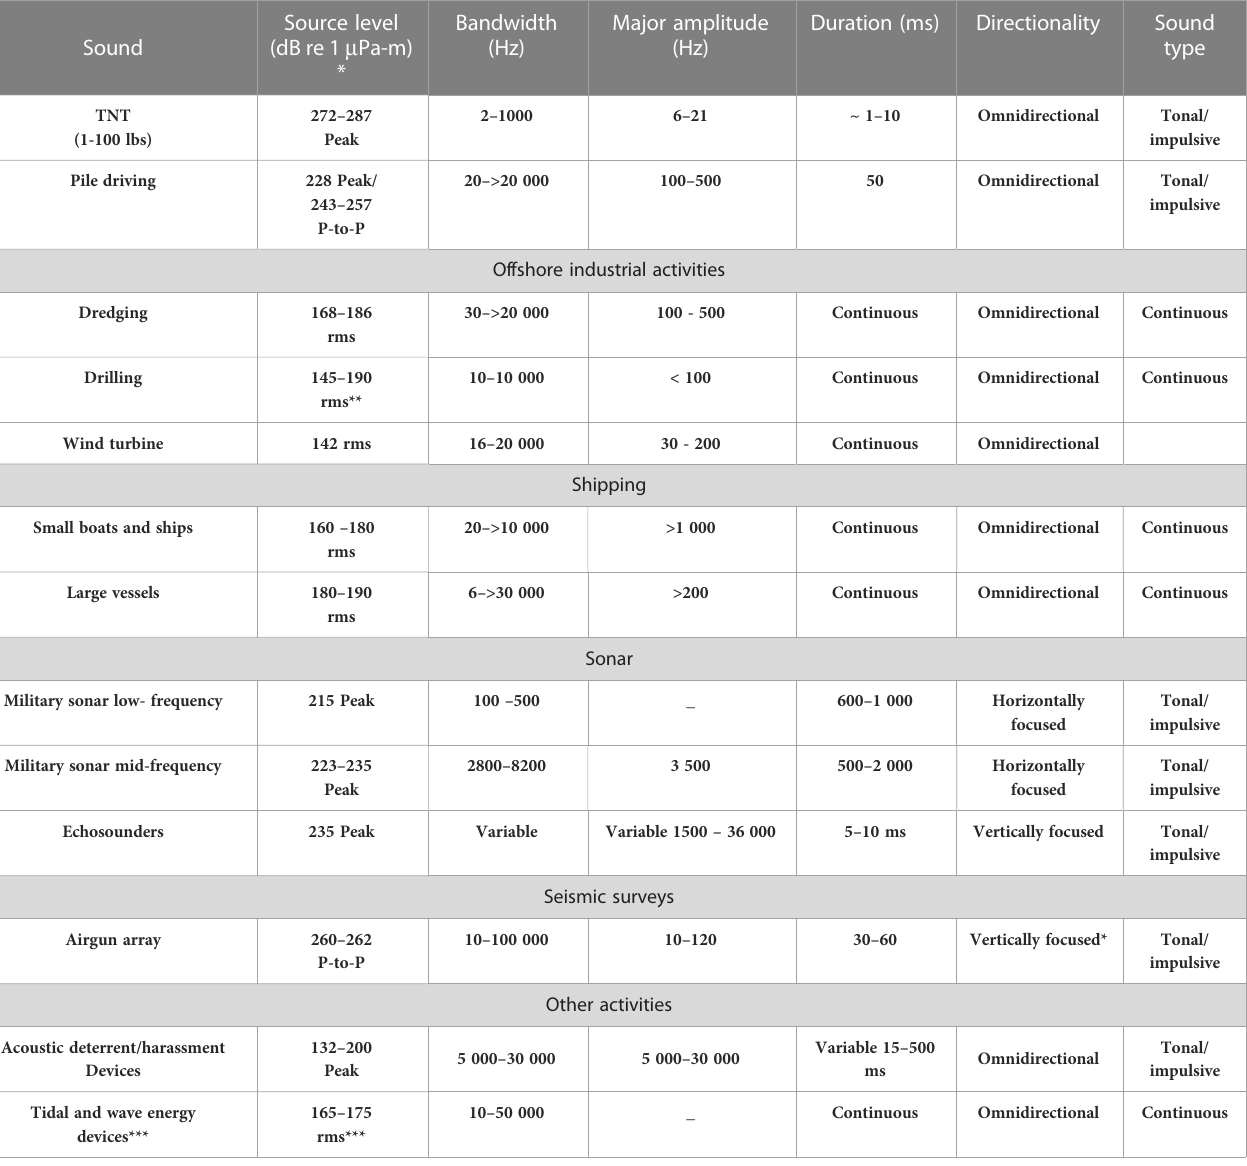
TABLE 1 Acoustic properties of some anthropogenic